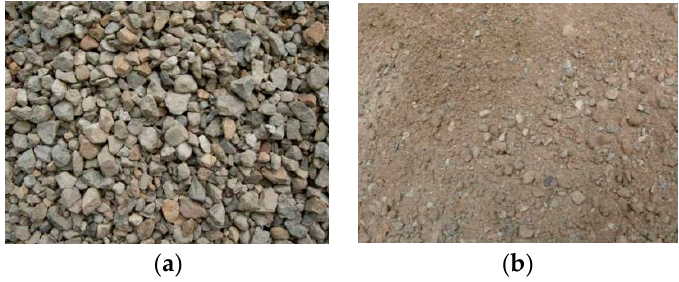
Figure 1. Recycled Aggregates. ( a ) Recycled Coarse Aggregates (RCA); ( b ) Recycled Fine Aggregates (RFA). Table 1. Basic physical properties of RCA and RFA.